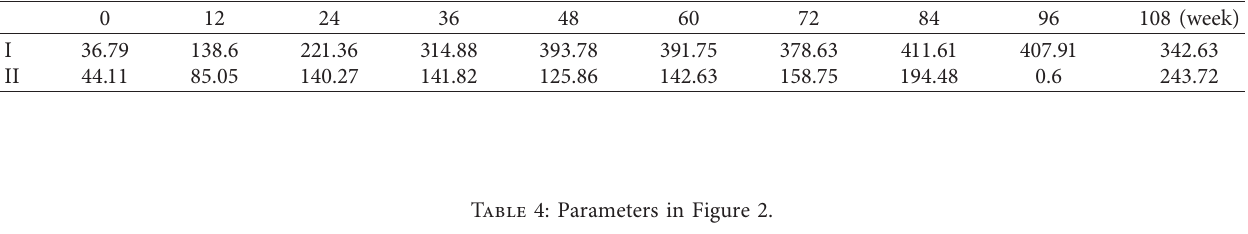
Table 3: HBeAg data of unsuccessful-treatment group.